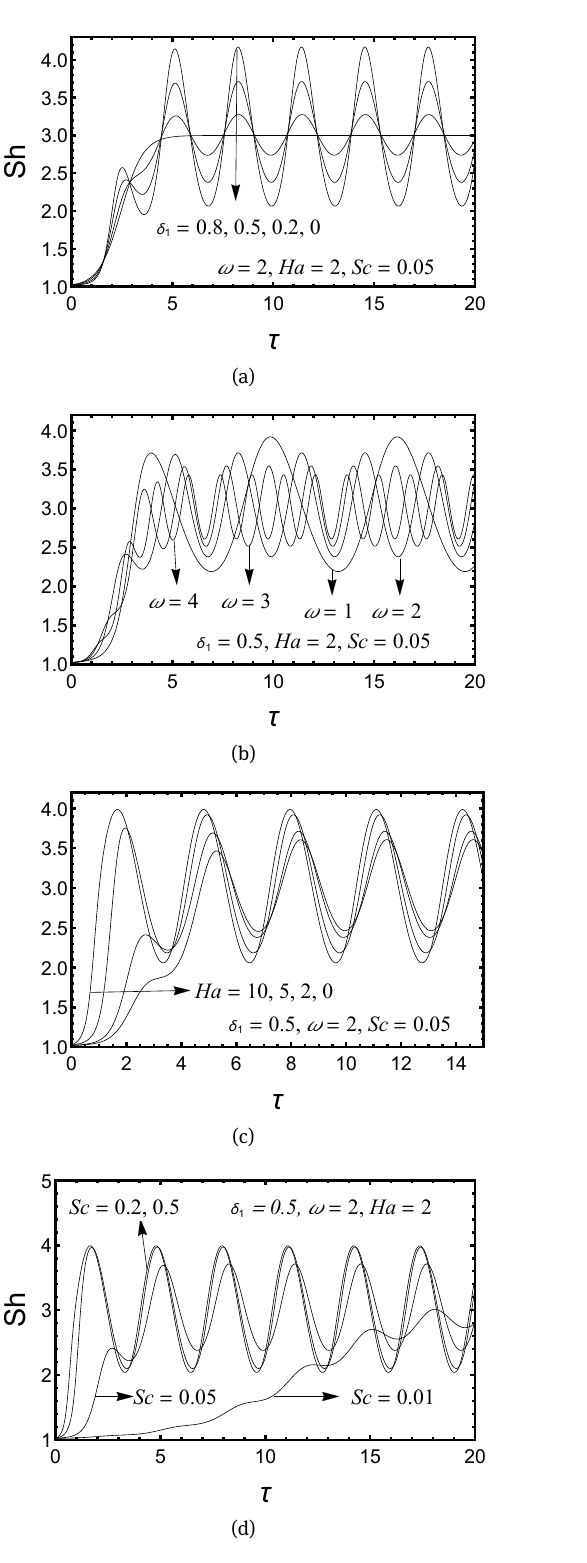
Fig. 3: Variation of Sherwood number Sh with time τ for only upper wall concentration is modulated while the lower one is held at con- stant concentration ( φ = − i ∝ ) for different value of (a) δ 1 , (b) ω , (c) Ha , (d) Sc